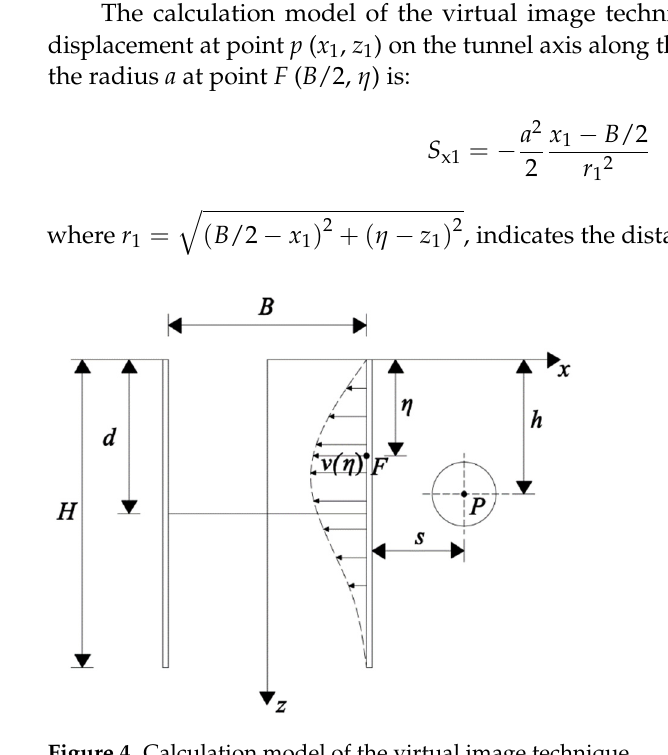
Figure 3. Analysis flow chart of the virtual image technique.